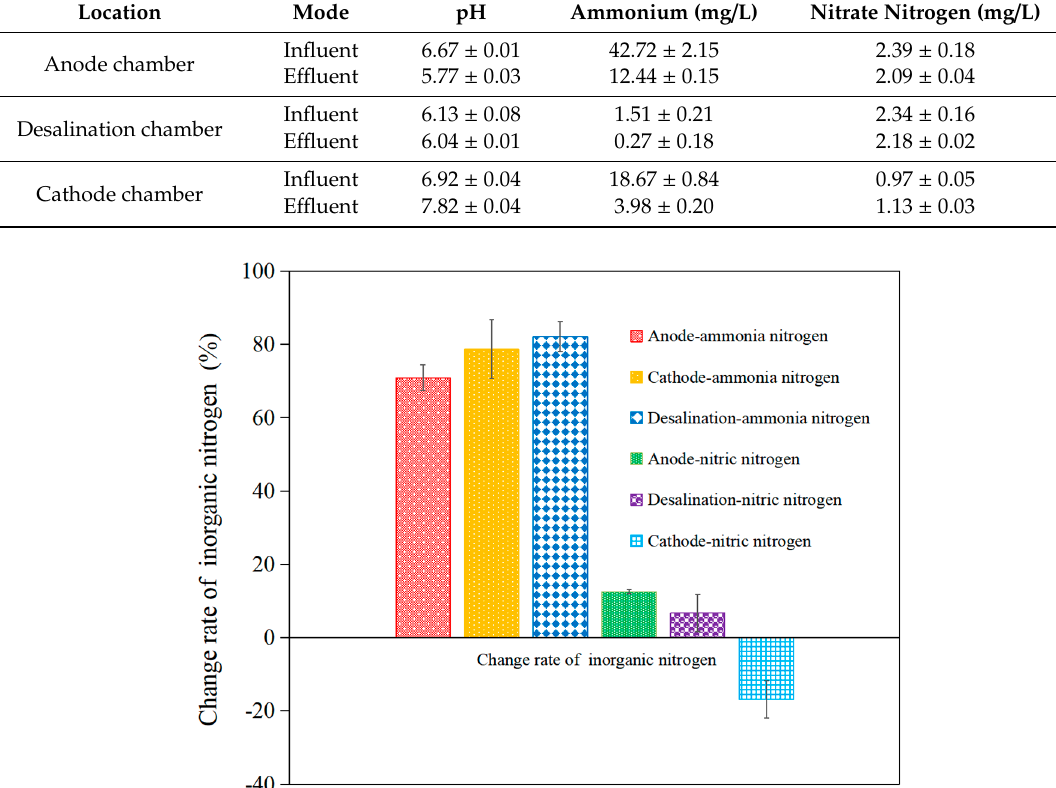
Figure 8. Change efficiency in inorganic nitrogen concentration of the AMDC. Figure 8. Change e ffi ciency in inorganic nitrogen concentration of the